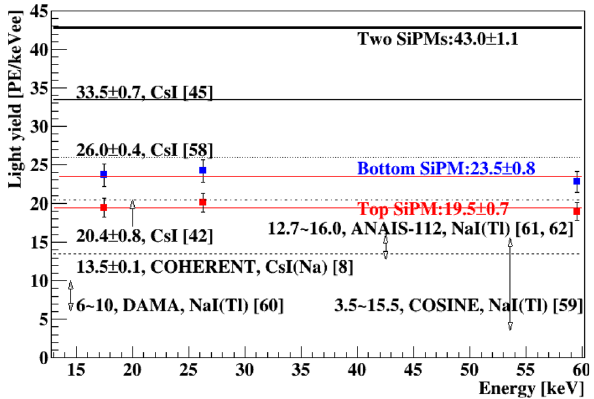
Fig. 12 Light yields measured for scintillators made of iodide com- pounds from various experiments [8,42,45,58–62]. All were measured with PMTs except for the one in this work. The arrows only represent ranges of light yields, their locations do not indicate energies where measurements were done